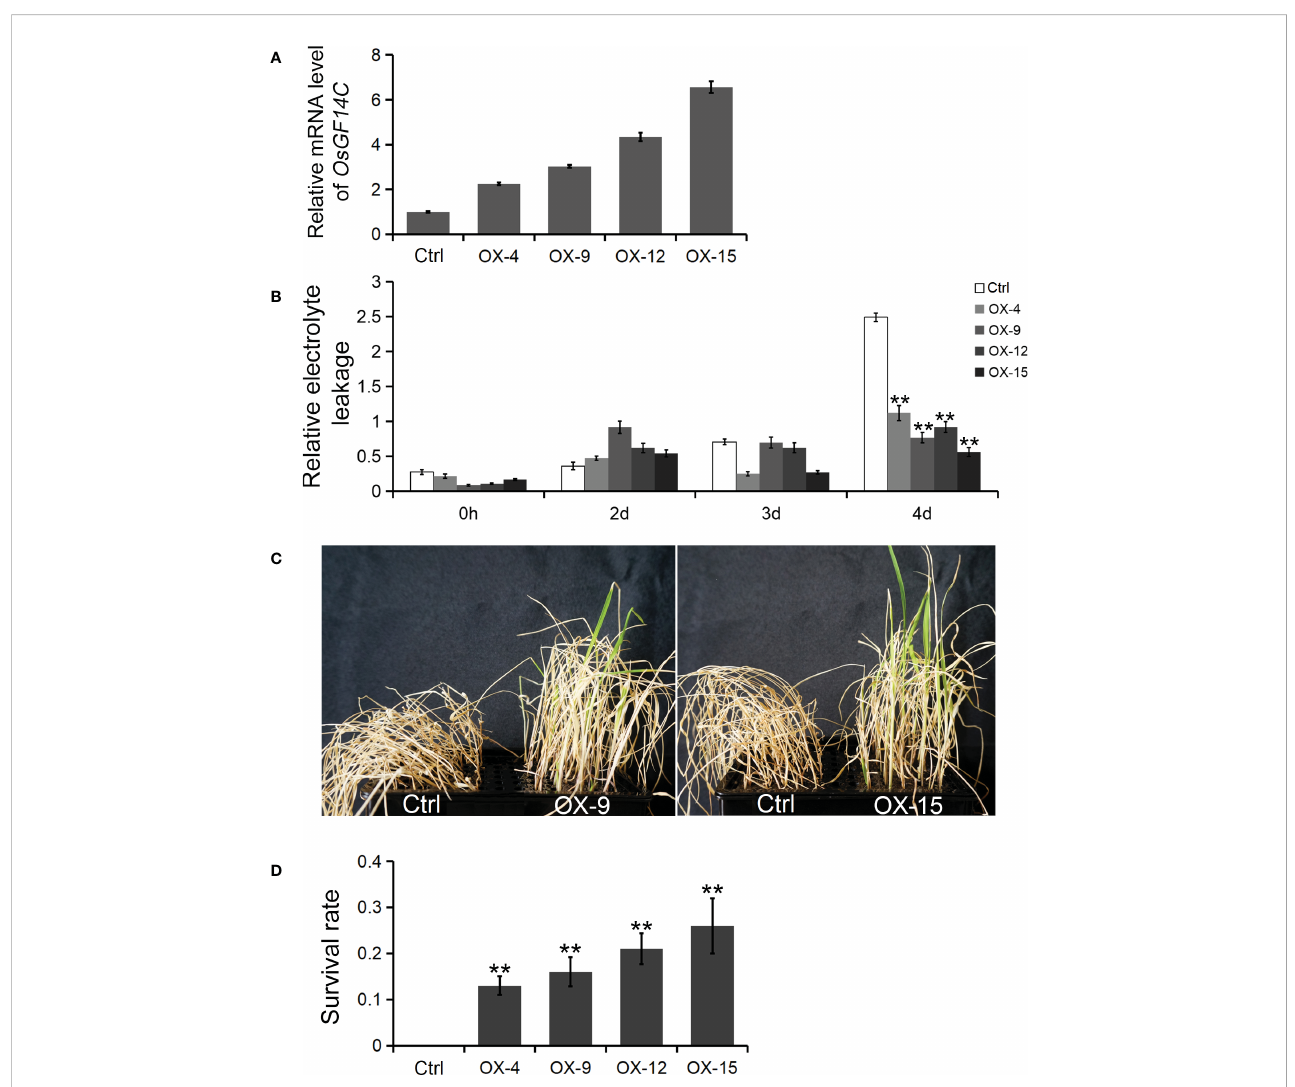
FIGURE 2 The role of OsGF14C in resistance to salinity stress in rice. (A) , the relative OsGF14C transcription level of four independent homozygous lines (OX-4, OX-9, OX-12 and OX-15) used in salinity tolerance evaluation experiment; (B) , the relative electrolyte leakages of Ctrl, OX-9, and OX-15 on the forth day after salinity treatment; (C) , the growth state of Ctrl, OX-9, and OX-15 after seven days of salinity treatment and ten days of recovery; (D) , the survival rate of Ctrl, OX-4, OX-9, OX-12 and OX-15 after seven days of salinity treatment and ten days of recovery. Error bars indicate the standard deviation (SD) from three biological replicates and ** indicates a statistically signi fi cant difference compared with 0 h treatment ( t test, p